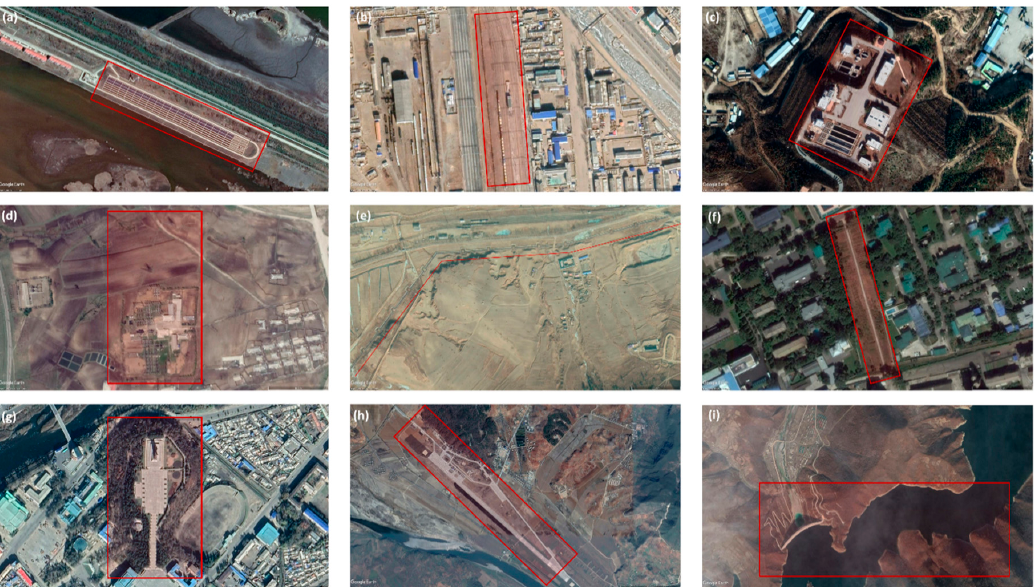
Figure 9. Multiple examples of urban structures on certain land parcels: ( a ) solar panels (in Kumsanpho solar power station), ( b ) railroads (in Rajin), ( c ) drinking water production facilities (in Kaesong), ( d ) a transmission tower (in Electric power transmission office in Sepho), ( e ) pipelines (in Seungri chemical complex refinery in Rason), ( f ) footpaths (in Pyeongyang), ( g ) public heritage (in Hyesan), ( h ) military site (in Pukchang), ( i ) reservoir (in Ryongrim) (image sources: Google Earth, date of access: 17 October 2019).